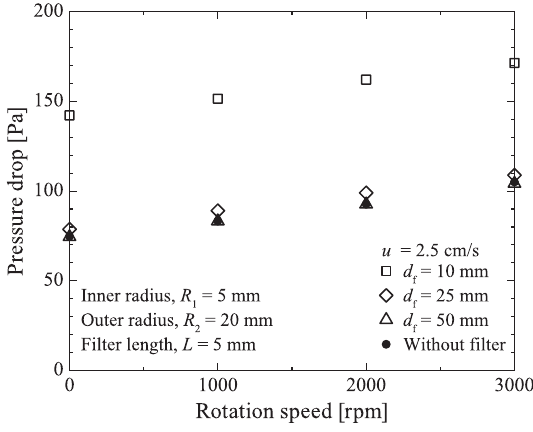
Fig. 11 Pressure drop of centrifugal filter at the filtration ve - locity of 2.5 cm/s.